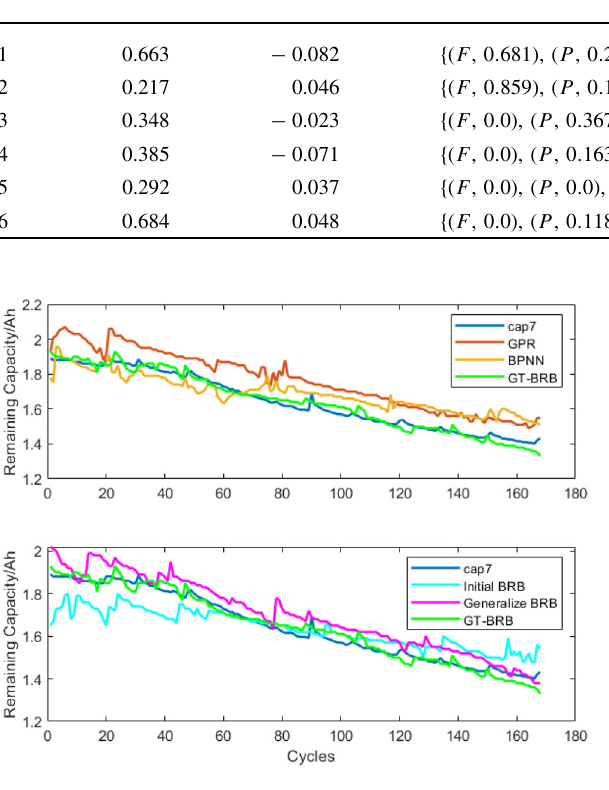
Fig. 7 The remaining capacity estimated by each method